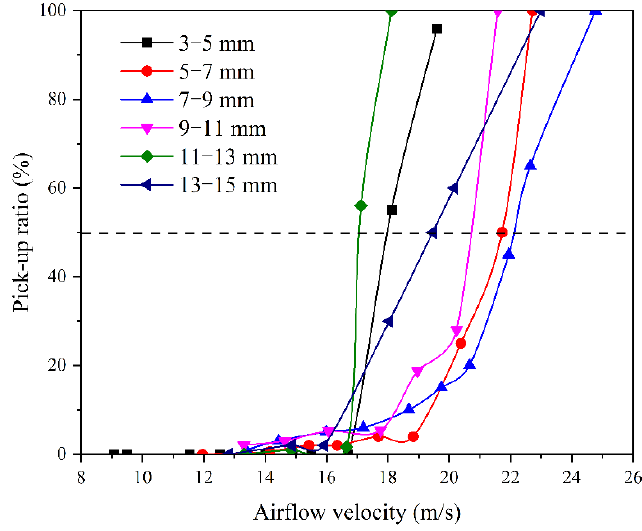
Figure 9. Pick-up ratio of pebble particles with different particle sizes.